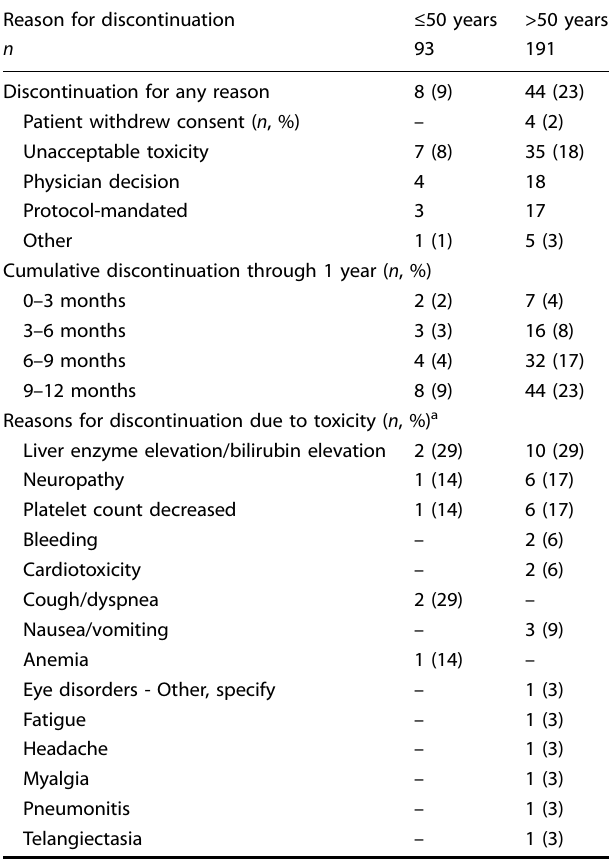
Table 2. Reasons for trastuzumab emtansine (T-DM1) discontinuation by age